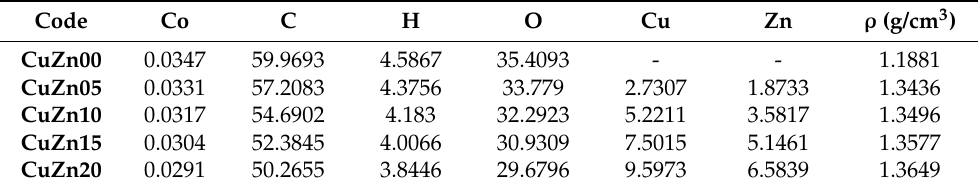
Table 1. Samples codes, elemental compositions (wt%) and density ( ρ ) of